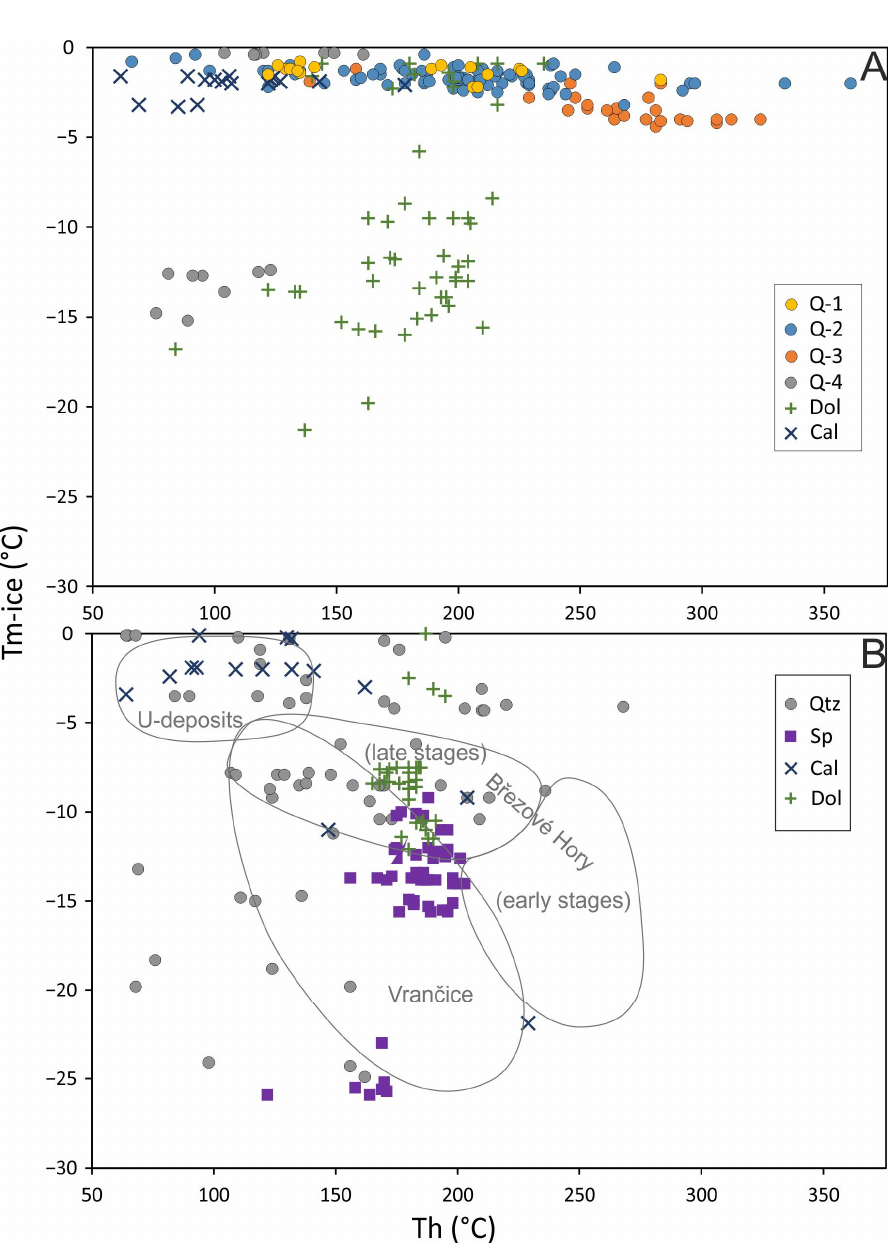
Figure 25. Total homogenization (Th) versus melting temperature of the last crystal of ice (Tm-ice) plot of fluid inclusions. ( A ) Data from the studied Au-bearing vein. ( B ) Comparative data from base-metal and uranium veins of the P ř íbram ore area. Symbols—data from base-metal vein Bt23C (Ulmanová et al. [5]) cutting the studied Au-bearing vein; fields—published data [87].